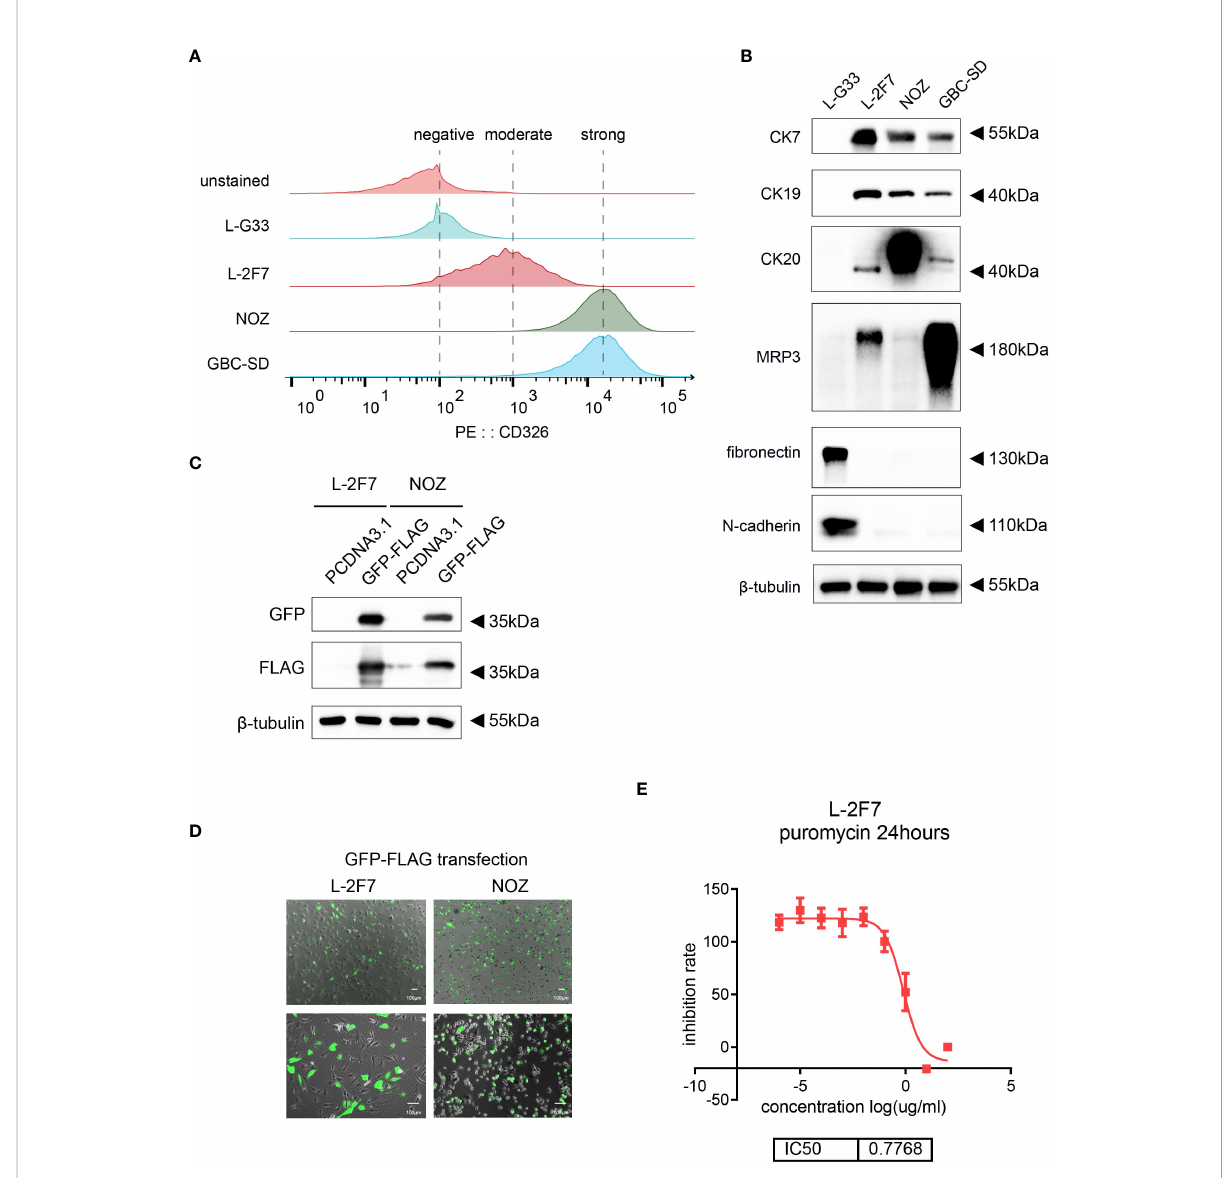
FIGURE 2 Identi fi cation of single clone cells L-2F7 for the epithelial signature. Epithelial markers were detected in L-2F7 cells, gallbladder cancer cell lines NOZ and GBC-SD, and L-G33 cells as a fi broblast control with fl ow cytometry (A) . CK7, CK19, MRP3, fi bronectin, and N-cadherin were determined with Western blot (B) . L-2F7 cells were transfected by GFP-FLAG, then the expression of GFP and FLAG was detected by Western blot (C) and fl uorescence was applied for observing the transfection ef fi ciency (D) . The sensitivity of puromycin in L-2F7 cells was measured by calculating IC50 from the fi tted curve (E)